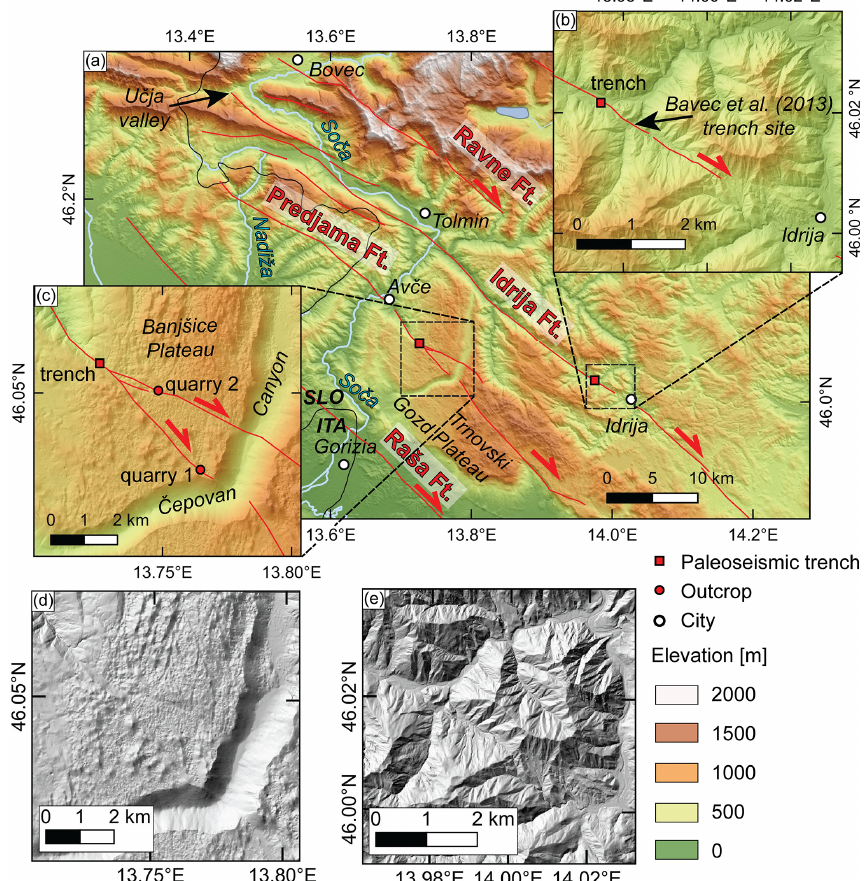
Figure 2. The study sites in NW Slovenia. Faults are from Moulin et al. (2016) and our own mapping. (a) Overview map (DEM from SRTM1). (b) At the Idrija Fault, the trench site is close to the one of Bavec et al. (2013). (c) At the Predjama Fault, we trenched the single strand section of the fault. (d) Hillshade of the Predjama Fault trench site. (e) Hillshade of the Idrija Fault trench site. In (b) – (e) the DEM is based on the 1m lidar